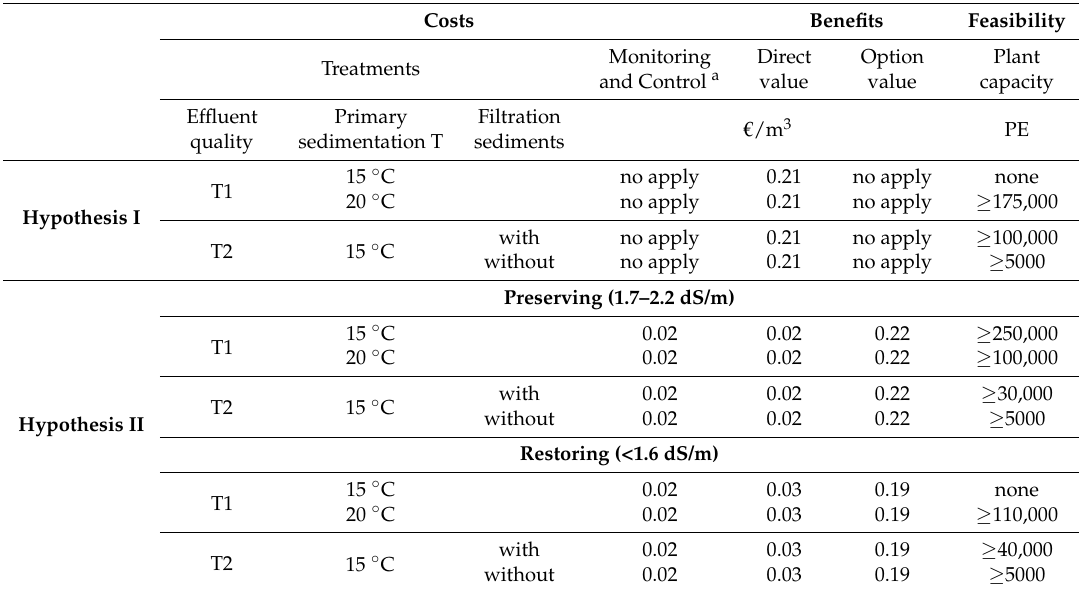
Table 8. Economic